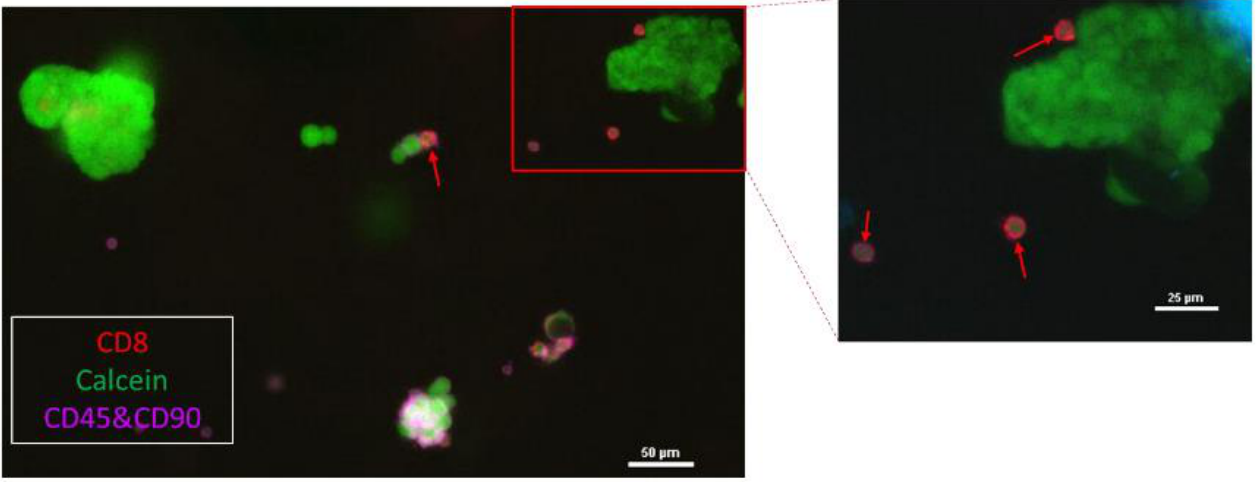
Figure A1. Immune profiling and viability evaluation of patient-derived thyroid tumor sphe- roids. A representative image of immunofluorescence staining that identifies the population of au- tologous CD45+ and CD8+ immune cells in organotypic tumor spheroids derived from patient sam- ples. Table A1. Spheroid live/dead and tumor – immune profiling. Experiment Spheroid Population Tumor Cell Ratio * Tumor Death Ratio ** Control 175000 ± 25% 0.22 0.090 PD-1 175000 ± 30% 0.16 0.196 CTLA4 130000 ± 25% 0.16 0.483 Combo 180000 ± 30% 0.13 0.433 * The ratio of tumor cells to the total population of spheroid cells (tumor + immune cells) for each drug treatment. ** The ratio of tumor cells to the total tumor cell population of spheroids (dead + live cells).